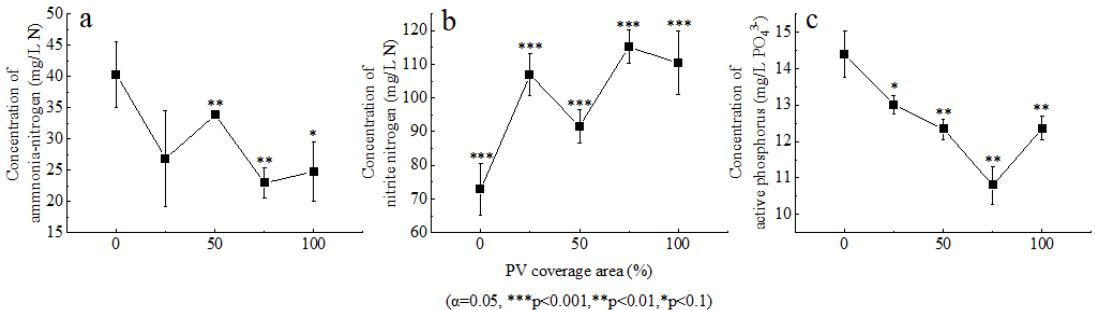
Figure 5. E ff ect of PV coverage area on the concentration of nitrogen and phosphorus. ( a ) Concentration Figure 5. Effect of PV coverage area on the concentration of nitrogen and phosphorus. ( a ) of ammonia-nitrogen changes under di ff erent PV coverage area, ( b ) Concentration of nitrite nitrogen Concentration of ammonia-nitrogen changes under different PV coverage area, ( b ) Concentration of changes under di ff erent PV coverage area, ( c ) Concentration of active phosphorus changes under nitrite nitrogen changes under different PV coverage area, ( c ) Concentration of active phosphorus di ff erent PV coverage changes under different PV coverage area.